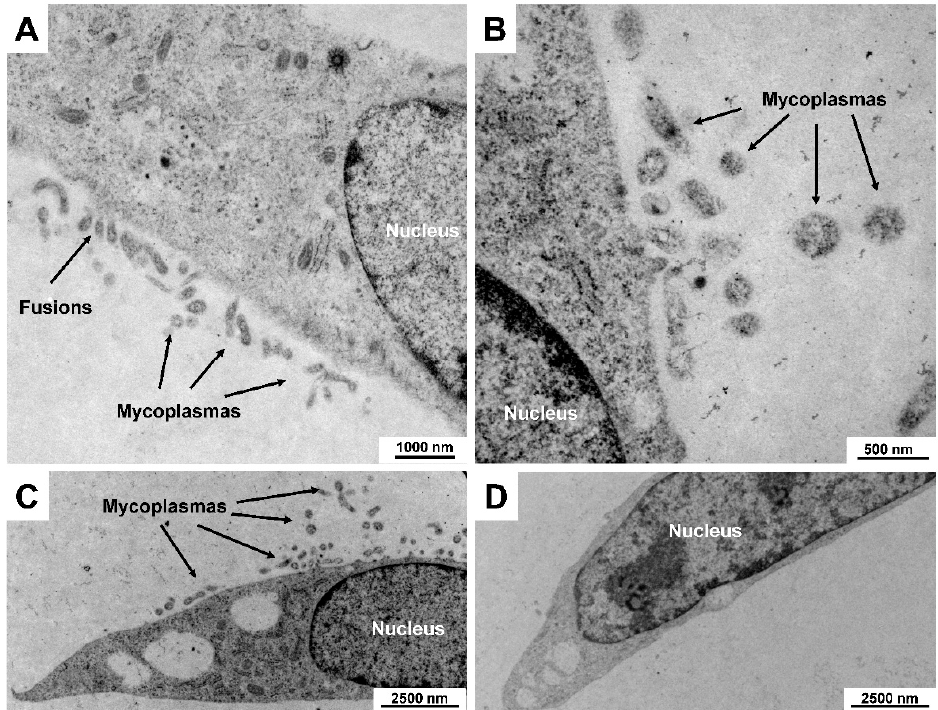
Figure 4. Clearance of mycoplasma contamination in a rat cell culture as assessed by electron micro- copy. A contaminated cell culture was treated with Plasmocin for 2 weeks. Shown are representative electron microscopic images of cells before ( A – C ) and after ( D ) treatment with the broad-spectrum anti-mycoplasma reagent showing that the mycoplasmas were successfully eliminated from the culture. Images were taken at original magnifications of 4646× to 27,800×. Please note the characteristic fusions of the mycoplasma membrane with the cytoplasmic membrane of the host cell in ( A ).